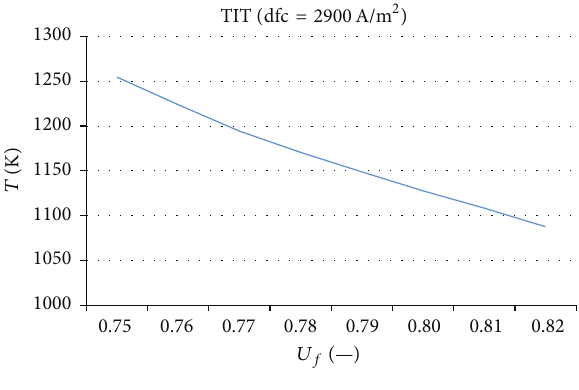
Figure 7: TIT at varying 𝑈 𝑓 .